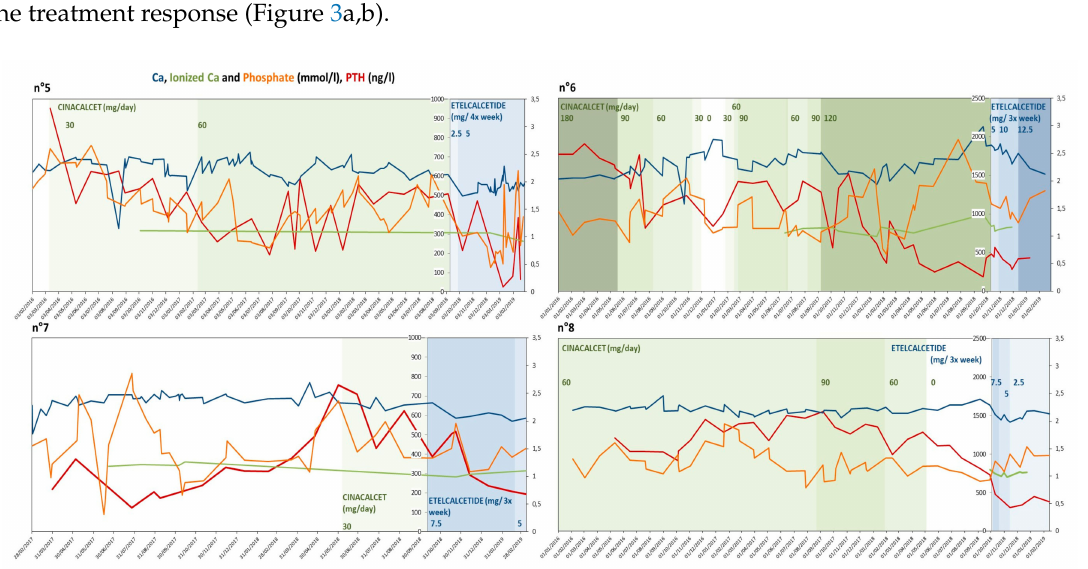
Figure 2. PTH, calcium and phosphate levels in patients with 5–6 months of follow-up. Legend: Ca calcium; PTH parathyroid hormone. N patient